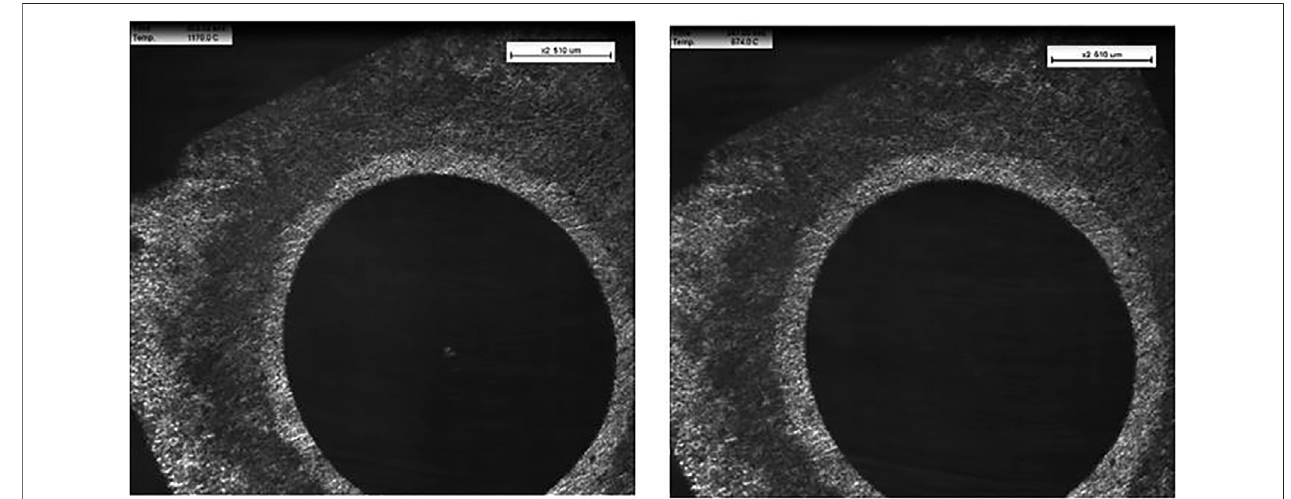
FIGURE 10 | Images from the confocal laser scanning microscope video at two different time points showing a ring appear around the inclusion.